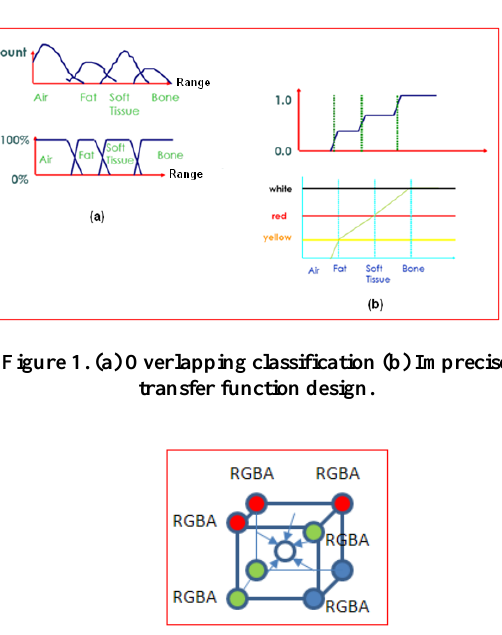
Figure 2. An ambiguous interpolation result originates from multiple vector parameters.